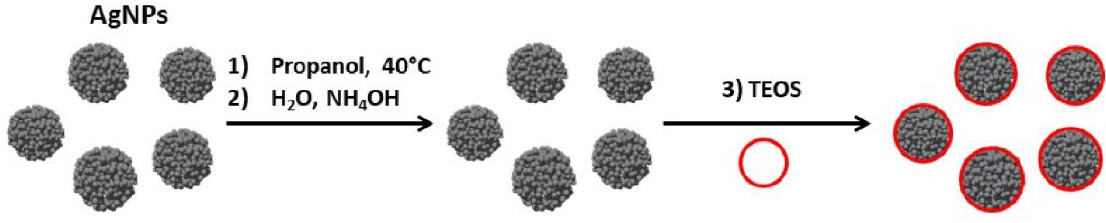
Figure 12. Modified Stöber method for coating of AgNPs with silica.